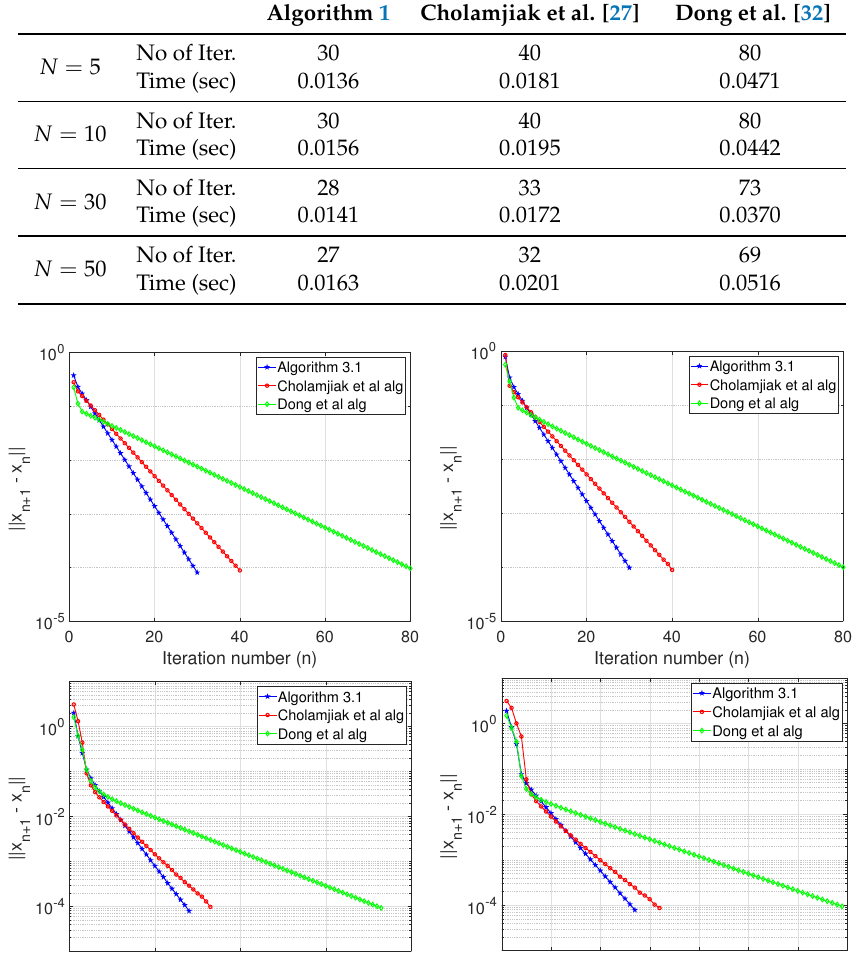
Algorithm 3.1 Cholamjiak et al alg